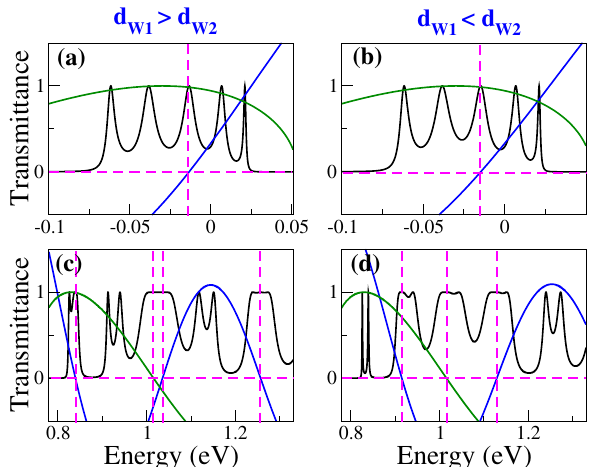
Figure 12. The same as Fig. 5, but here Tr ( M B M W 1 ) (solid-blue curve) and sin ( q x d B ) (solid-dark-green curve) are included to unravel the origin of transparent states. The dashed-magenta lines help to identify the energies at which Tr ( M B M W 1 ) and sin ( q x d B ) are zero.